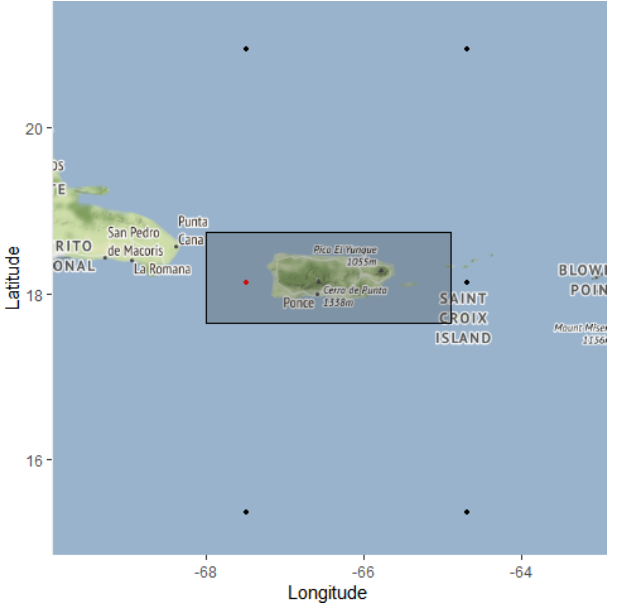
Figure 4. The bounding box for which GCM coordinates are kept (latitudes range from 17.65 to 18.75 ◦ , and longitudes range from − 68.00 to − 64.90 ◦ ). The CanESM2 location inside the box (red) is kept, while CanESM2 locations outside the box (black) are not kept. This image was created using a combination of © Google Maps 2018, Kahle and Wickham (2013), and Wickham